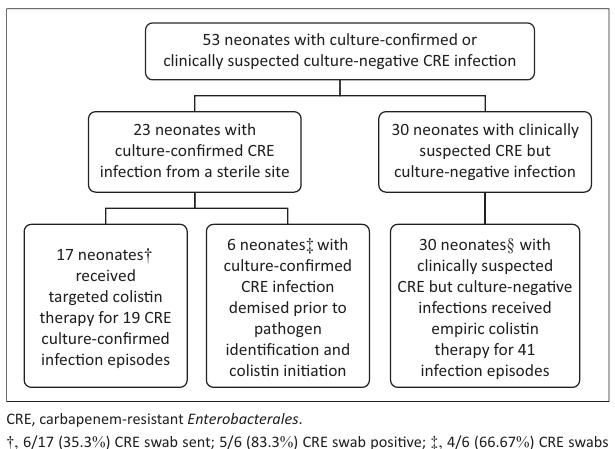
FIGURE 1: Derivation of the study